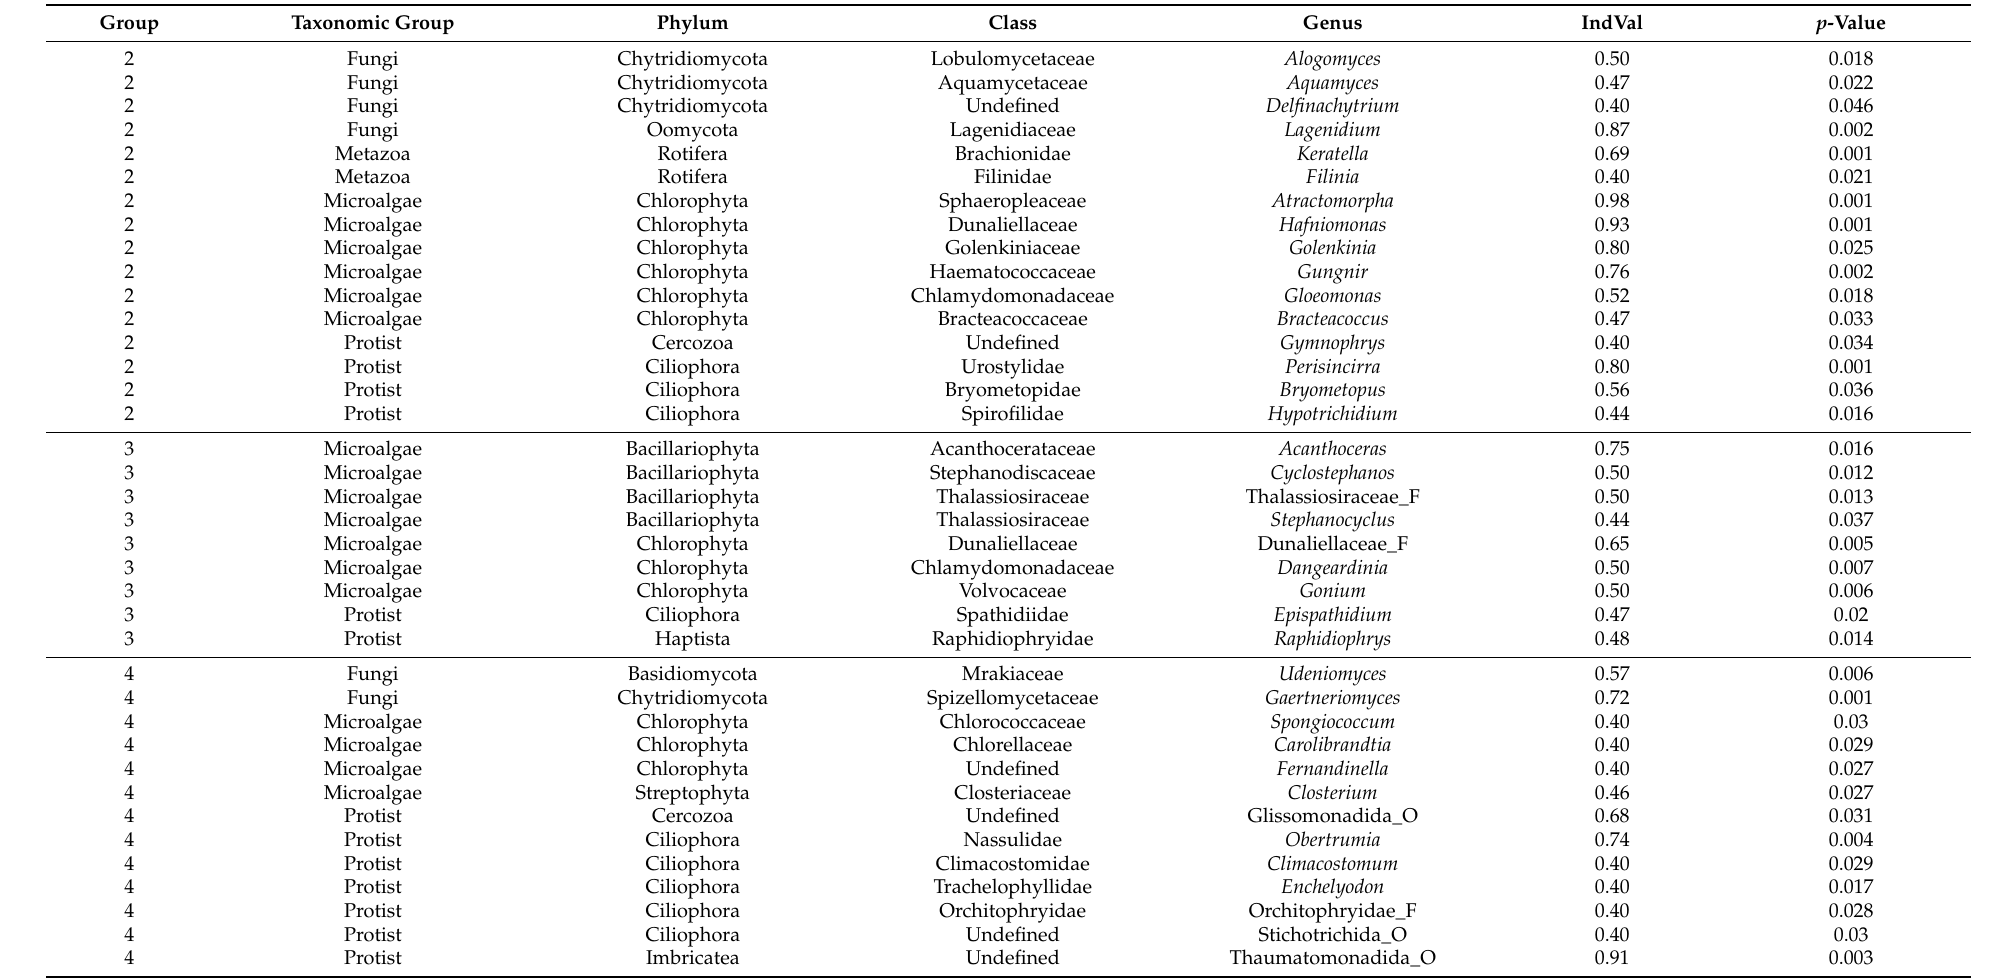
Table 3. Results of the indicator species analysis in four groups (i.e., seasons) at the SJ site. Only taxa with significant values are shown (2: summer, 3: autumn and 4: